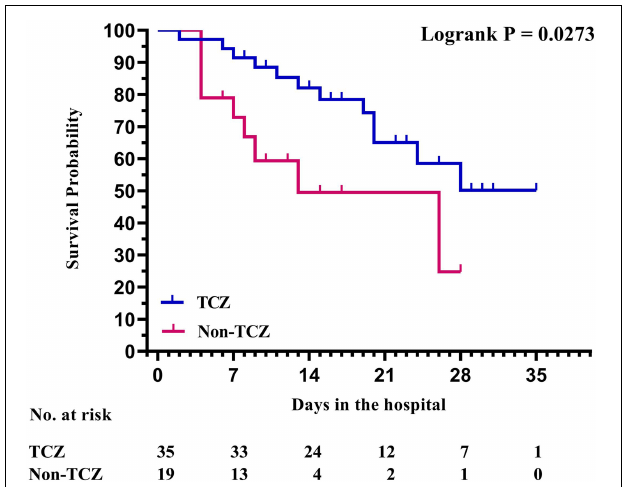
FIGURE 3 | Survival analysis with Kaplan–Meier curves between patients with COVID-19 treated with or without tocilizumab.